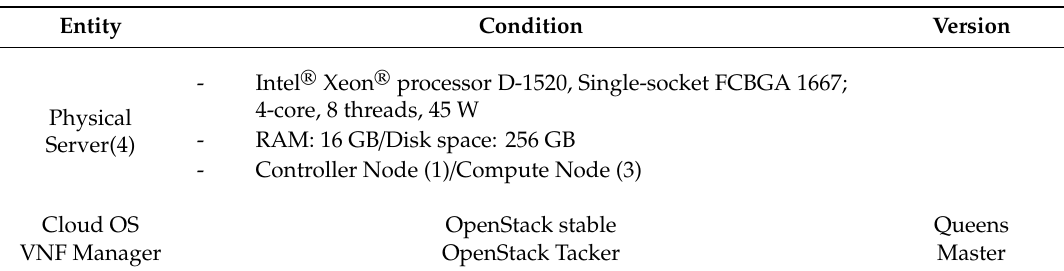
Table 2. Implementation specifications.